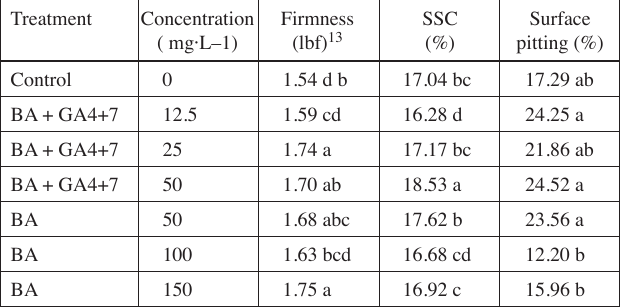
Tab. 3: Effects of benzyladenine (BA) and BA + gibberellins (GA 4+7 ) ap- plications on firmness, soluble solids content (SSC), and